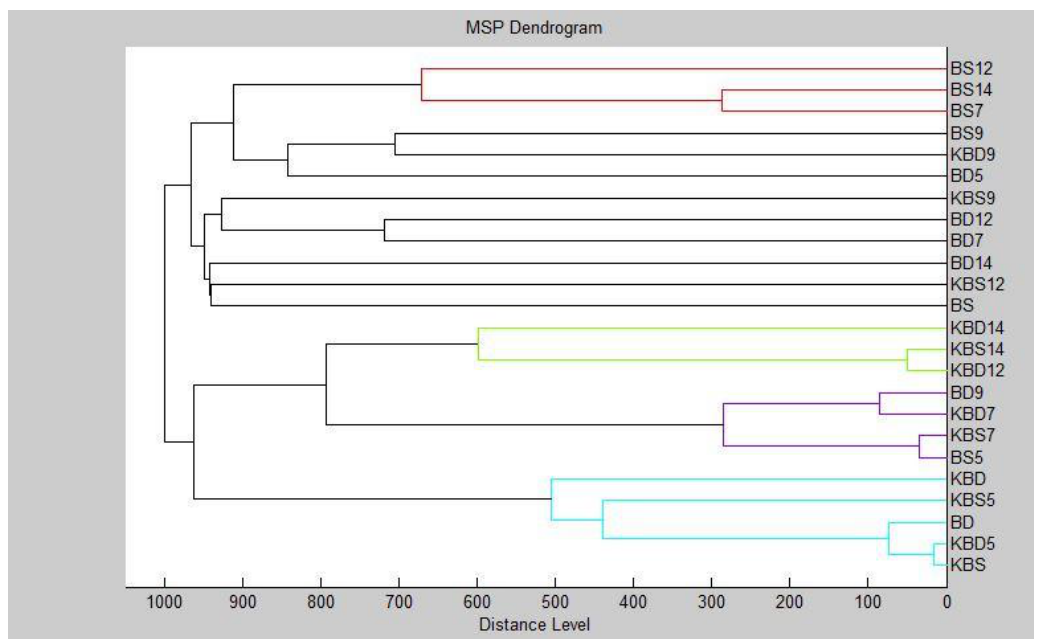
Figure 5. Dendrogram of B . subtilis generated using the MSPs for all experimental group: B- B. subtilis ; K-control; S-glass; D-wood.